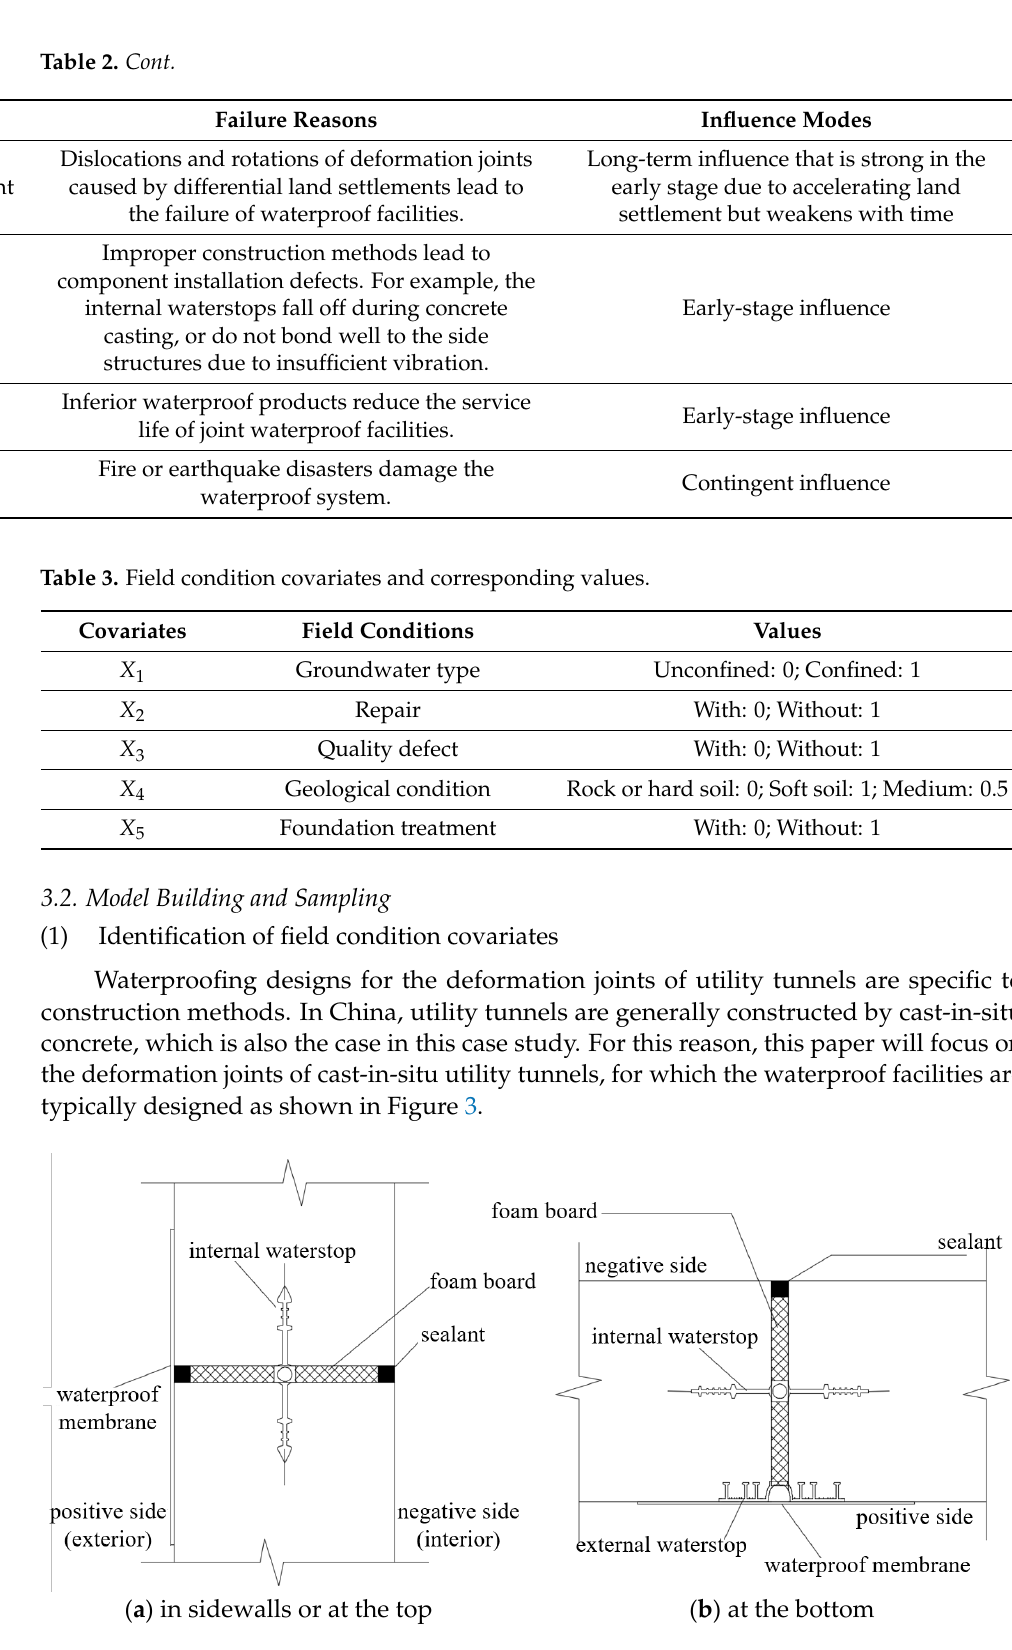
Figure 3. Waterproofing designs for the deformation joints of cast-in-situ utility tunnels.